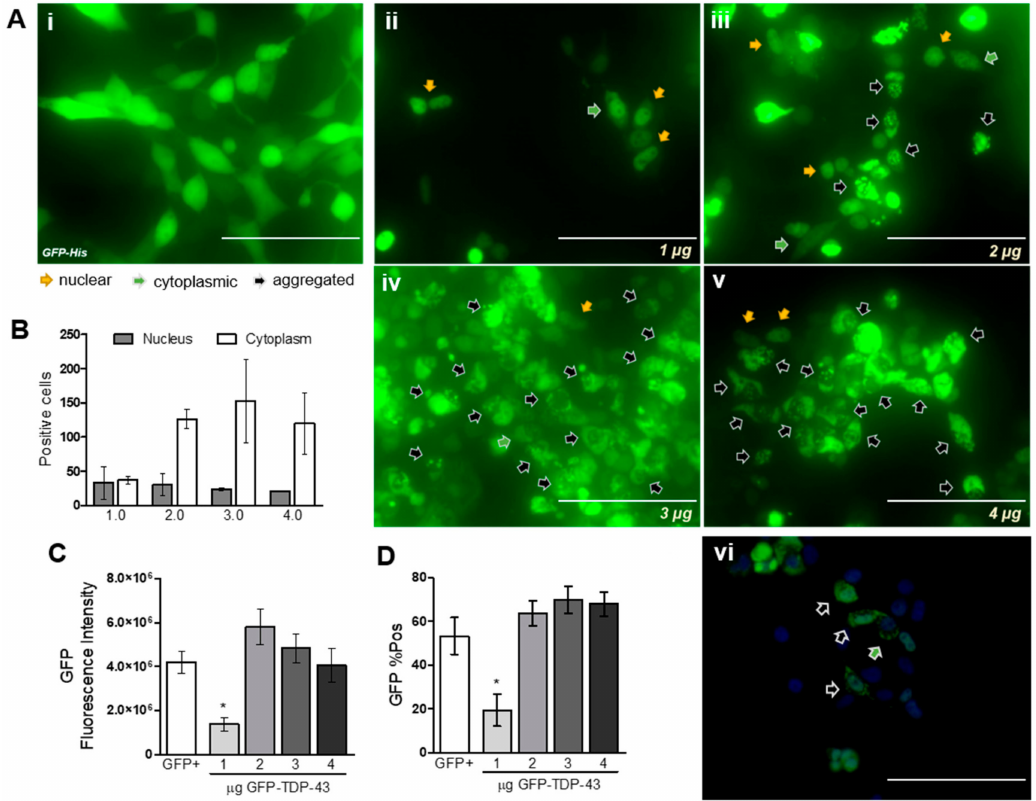
Figure 1. HEK293T transfection with increasing quantities of GFP-TDP-43 induces an increase in TDP-43 expression and cytoplasmic aggregation. ( A ) i Control cells transfected only with GFP (4 µ g) show presence of GFP signal in the whole cell. ( A ) ii–v Increasing concentrations of GFP-TDP-43 showing di ff erent cellular distributions (observed in detail in ( A ) vi; scale bar = 100 µ m). Cell nucleus was counterstained with DAPI (2 µ g / mL; Sigma–Aldrich). Scales bar = 200 µ m for ( A ) i–v. ( B ) The increase in expression was followed by an increase in the number of cells presenting cytoplasmic aggregates ( n = 2). ( C ) and ( D ) Increase in the number of positive cells and median fluorescence signal for GFP analyzed by flow cytometry ( n = 5). Nonparametric Kruskal–Wallis test revealed * p < 0.05 for TDP-43 1 µ g when compared to GFP + group (positive control: cells transfected with 4 µ g of GFP